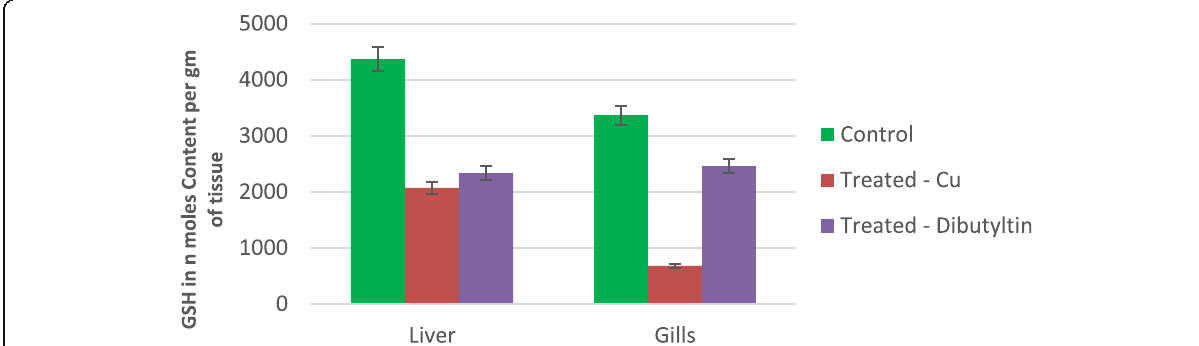
Fig. 5 Average GSH content in tilapia in liver and gills in control, Cu-treated and dibutyltin-treated. Data were expressed as mean and with standard deviation error